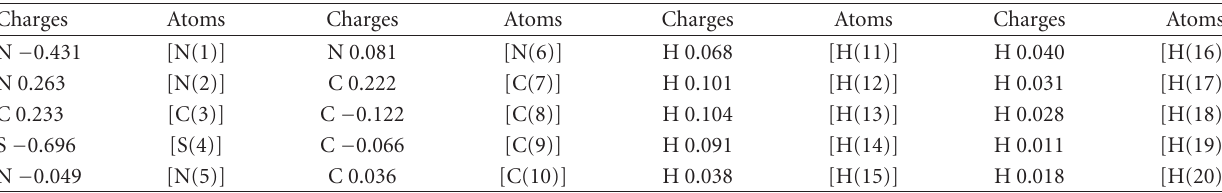
Table 5: Atomic charge of the